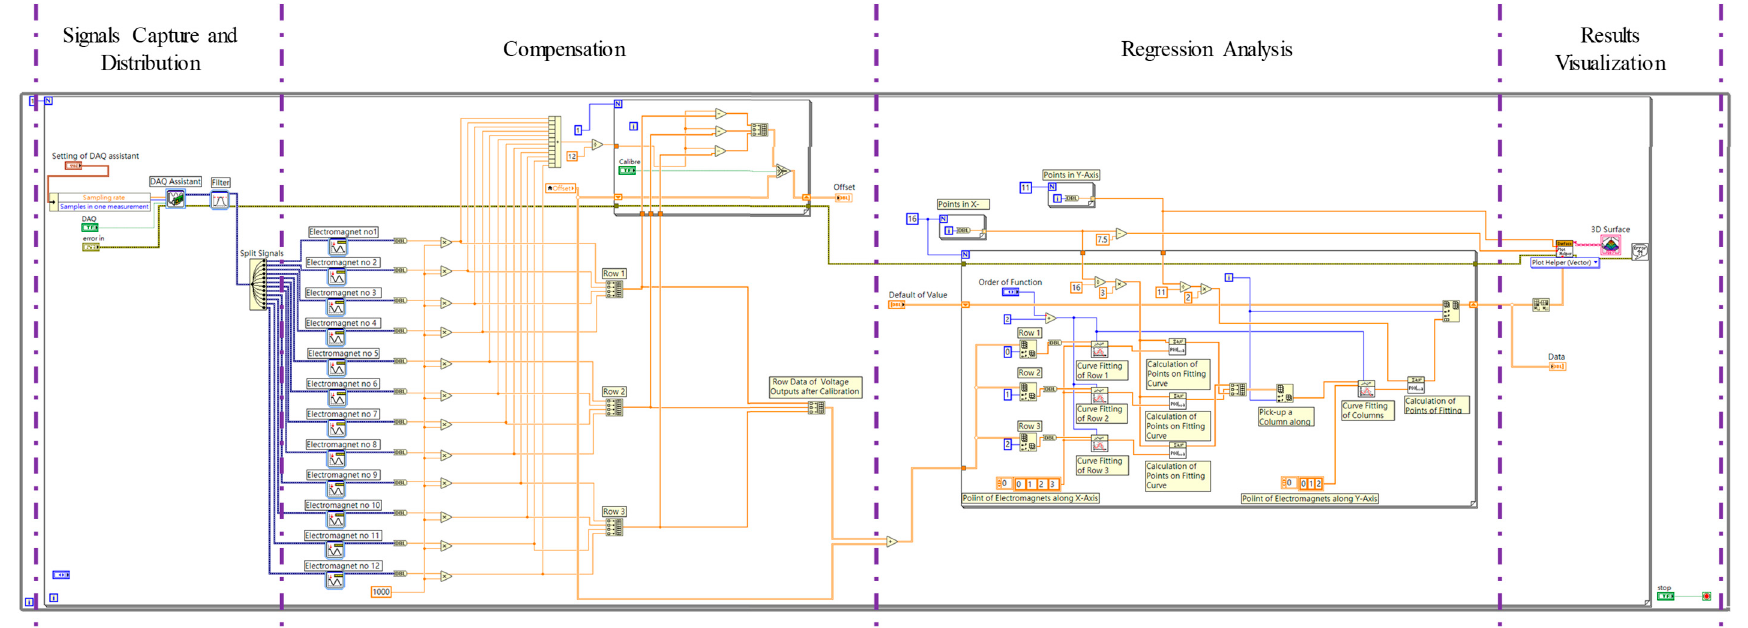
Figure 4. The block diagram of signal-processing program developed by using Labview software.